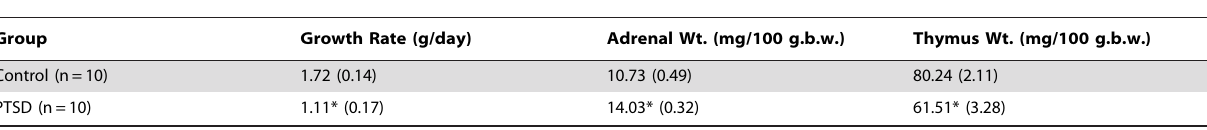
Table 2. Growth rate and organ weights.